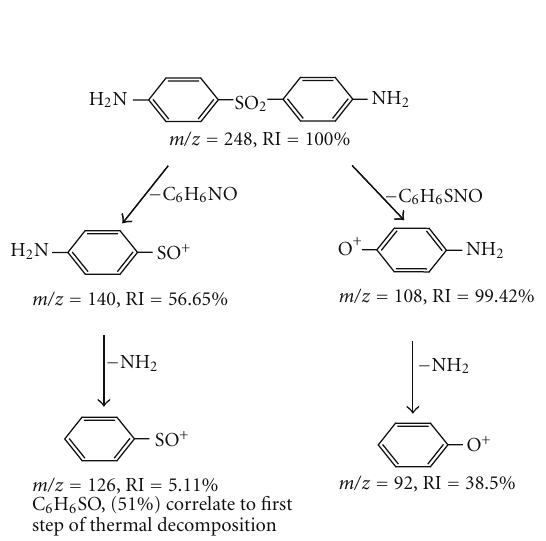
Scheme 2: Mass spectral fragmentation pathways of